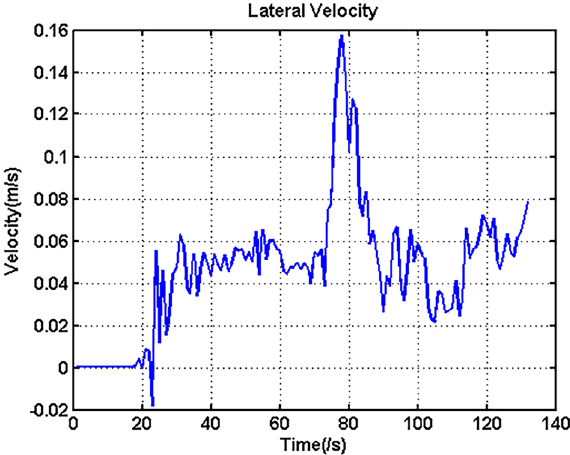
Figure 10. Lateral velocity of the UGV.